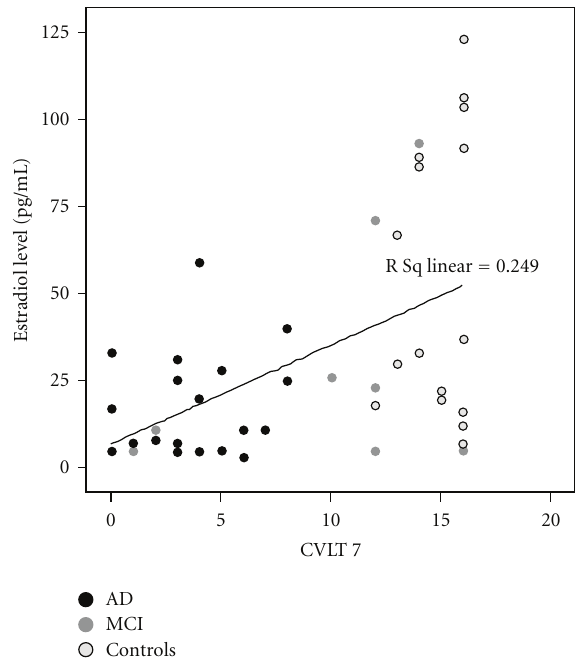
Figure 2: Association of estradiol level and CVLT delayed recall for all female